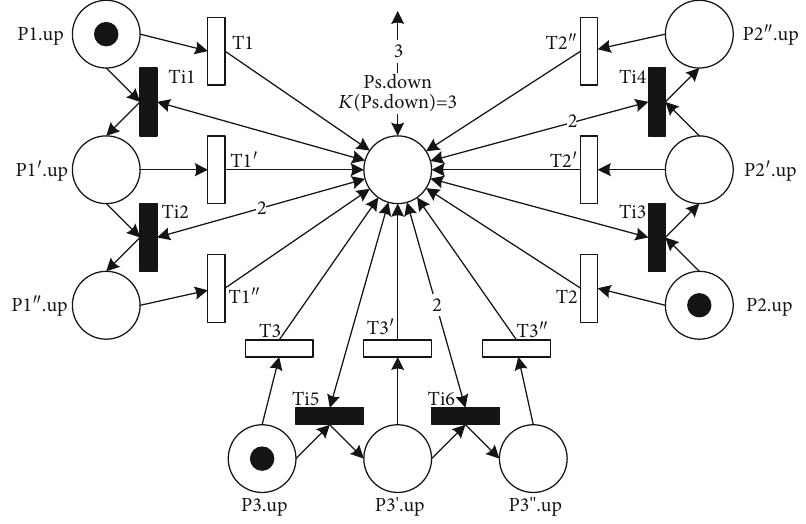
Figure 4: The model of a load-sharing architecture with three components.